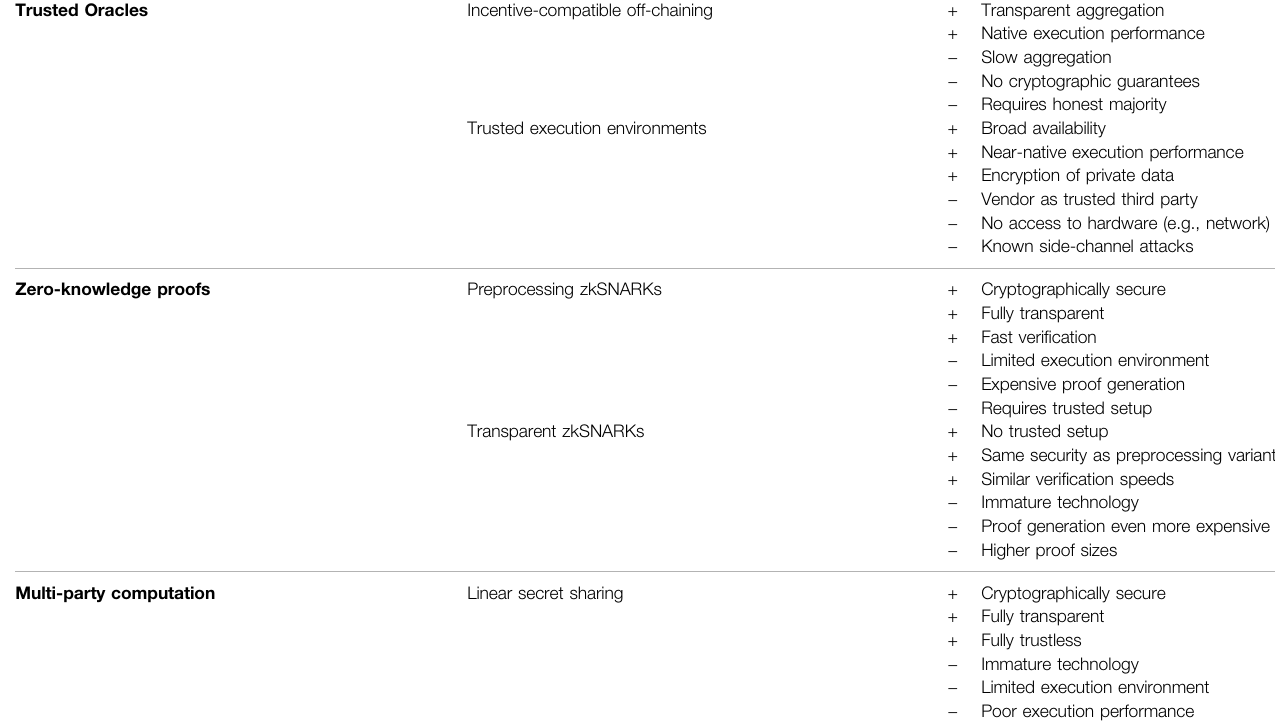
TABLE 1 | Overview of the presented veri fi able computation technologies, including pros and cons. Trusted Oracles Incentive-compatible